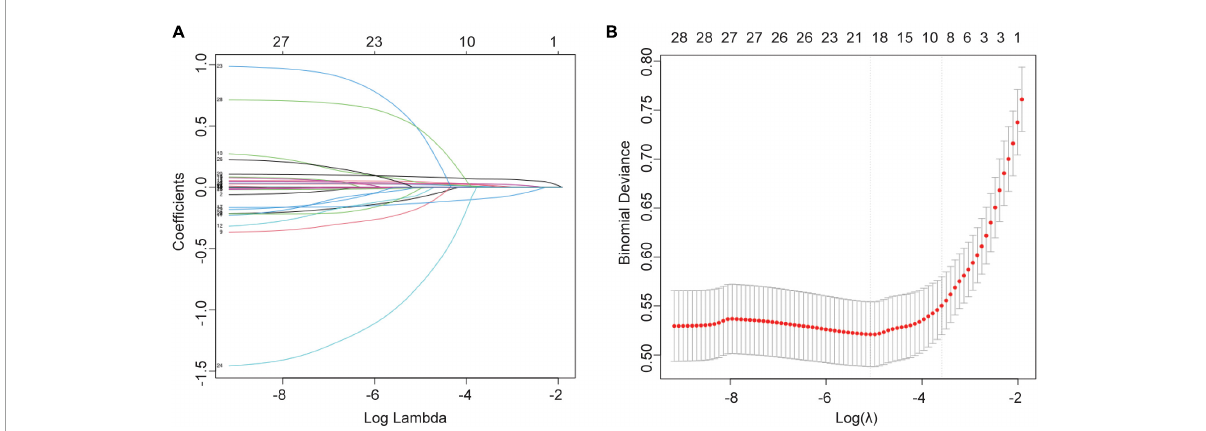
FIGURE2 Selection of variables for mortality were performed using the LASSO analysis. (A) Model coefficient trendlines of the 28 variables for mortality. The profile graph was plotted by coefficients against the L1 norm. (B) Tuning parameter λ in the LASSO model. The parameter ( λ = 0.068) was selected under the minimum criteria. The vertical line was drawn at the value selected by 10-fold cross-validation, including optimized 8 non-zero